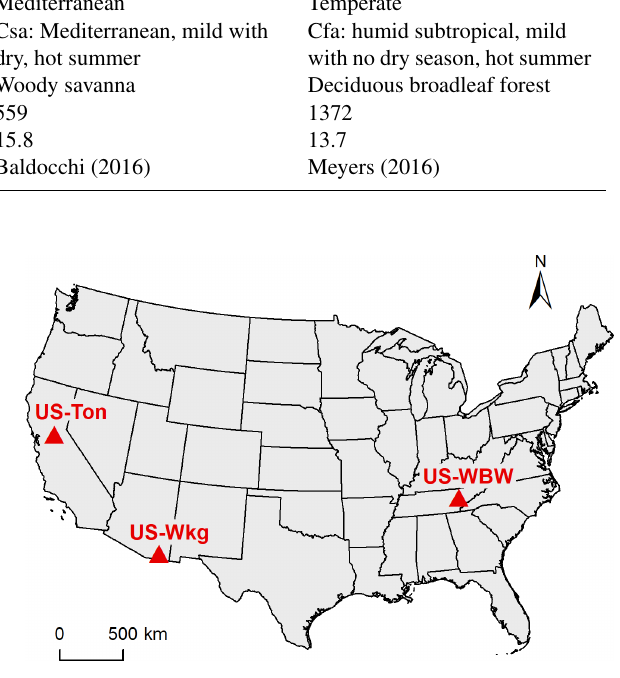
Figure 1. Location of study sites across the conterminous United